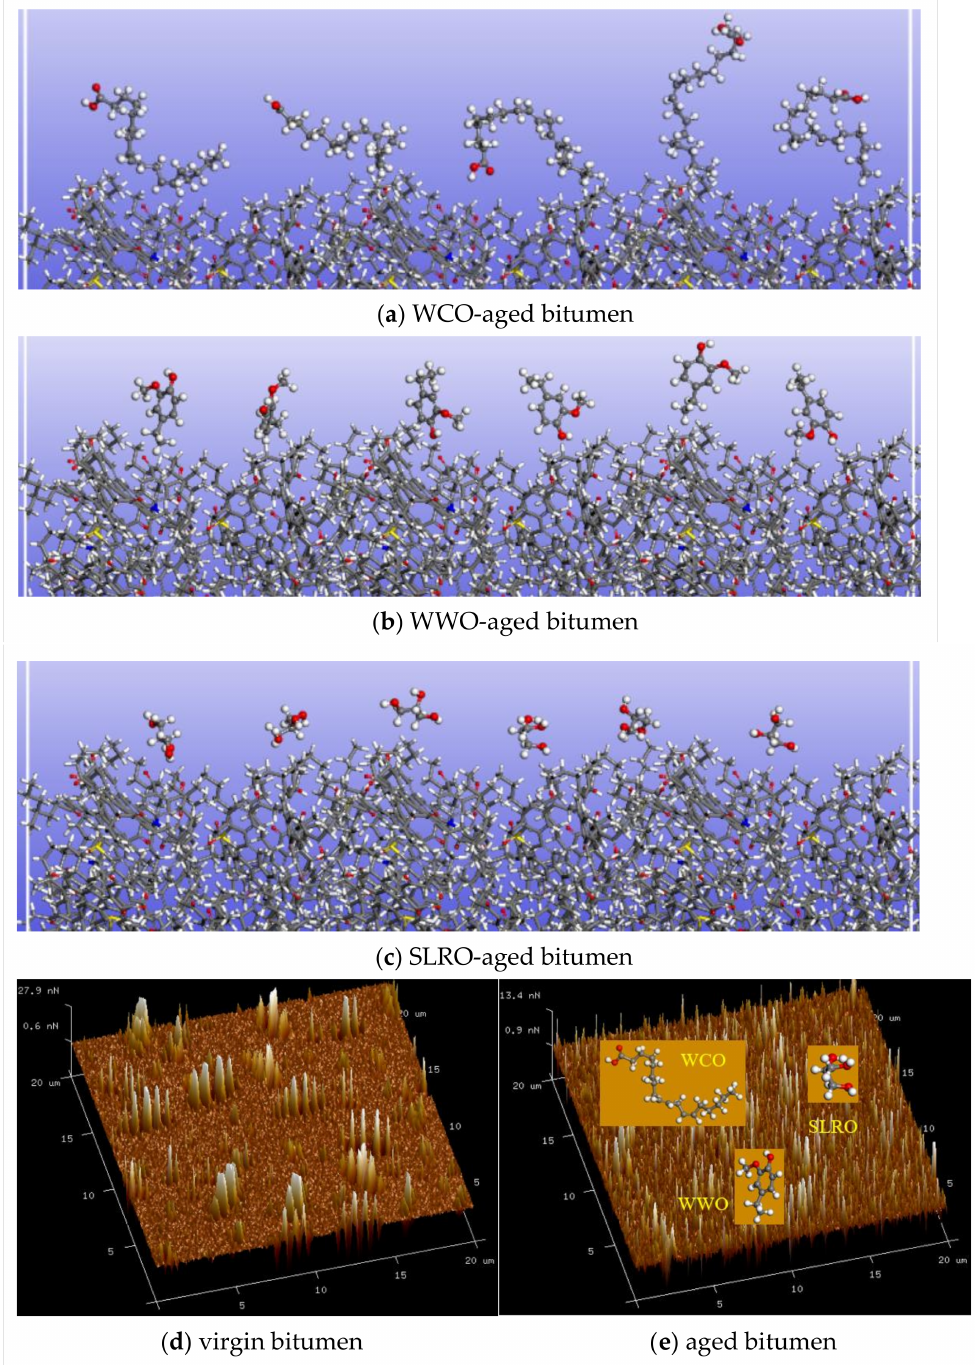
Figure 20. Molecular morphology of bio-oil during